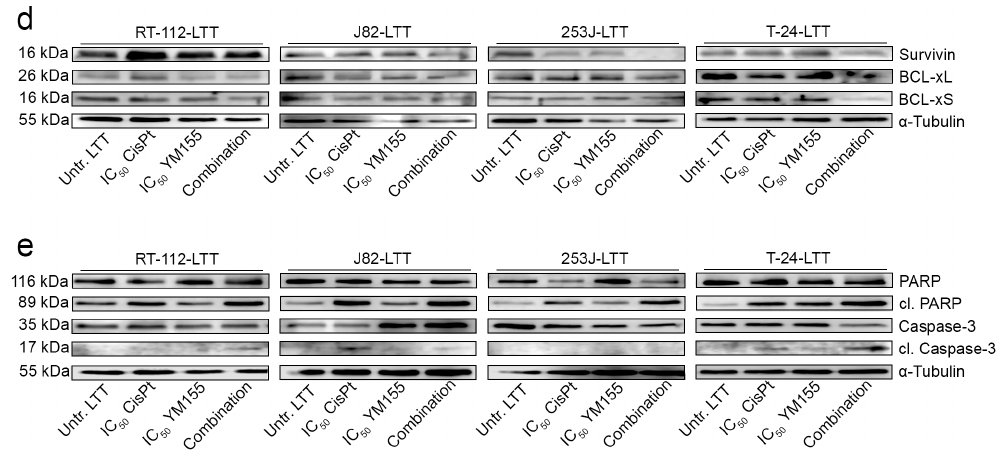
Figure 5. Pharmacological inhibition of Survivin by YM155 sensitised LTTs to cisplatin. ( a ) Cell viability was measured in untreated LTTs (set as 100) compared to LTTs treated with IC 50 concentration of cisplatin, IC 50 concentration of YM155, and the combination of both after 72 h by MTT assay. Values represent the mean ± SD of two independent experiments. * p < 0.05 CisPt vs. combination, # p < 0.05 YM155 vs. combination. Corresponding to combination indexes (CI) displayed in Table S5; ( b ) Colony formation assay of untreated LTTs compared to LTTs treated for 72 h with maintenance cisplatin concentration, IC 50 concentration of YM155, or the combination. Cell clones were stained by Giemsa; ( c ) Induction of apoptosis and necrosis was analysed in untreated LTTs and those treated with IC 50 concentration of cisplatin, IC 50 concentration of YM155, or the combination of both after 72 h by combined Annexin V and PI staining with subsequent flow cytometry as shown in a bar graph; ( d , e ) Survivin, BCL-xL, BCL-xS ( d ), PARP, cleaved PARP, Caspase-3, and cleaved Caspase-3 ( e ) protein expression was detected in LTTs treated with IC 50 cisplatin concentration, IC 50 YM155 concentration, and the combination of both after 72 h compared to their untreated controls. As a loading control, α -Tubulin was detected. One representative immunoblot is shown from two independent experiments.